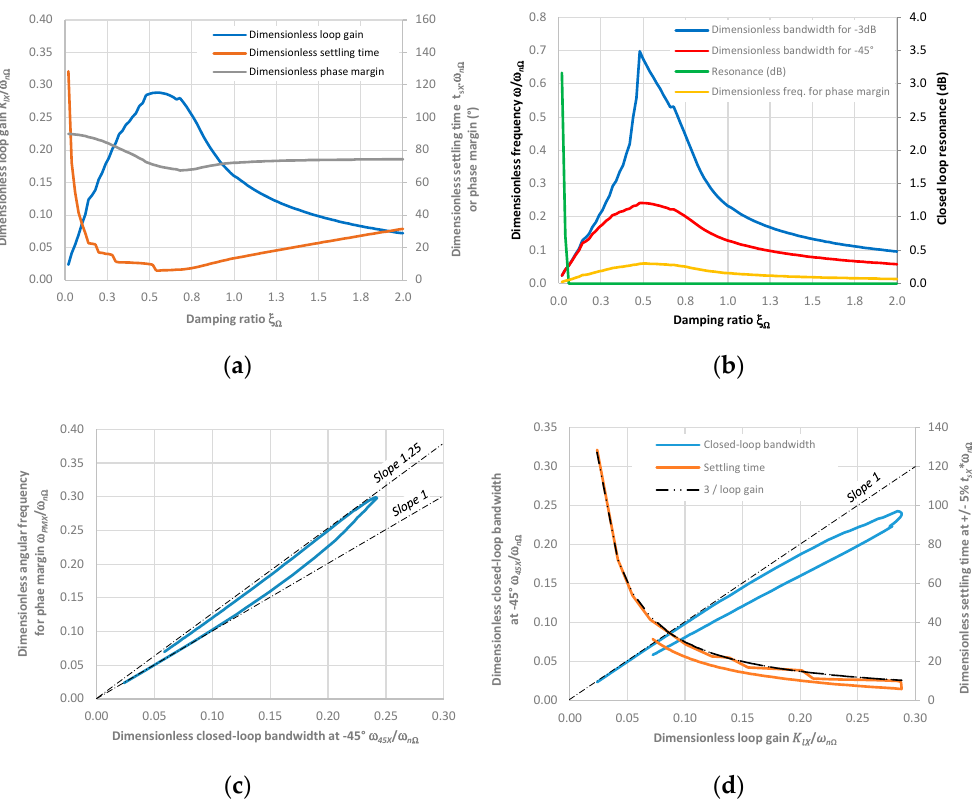
Figure 4. Performance indicators for position control for the fastest closed-loop step response without overshoot using dimensionless variables: ( a ) loop gain, settling time and phase margin; ( b ) performance indicators in the frequency domain; ( c ) frequency for the phase margin; and ( d ) closed-loop rapidity versus loop gain.